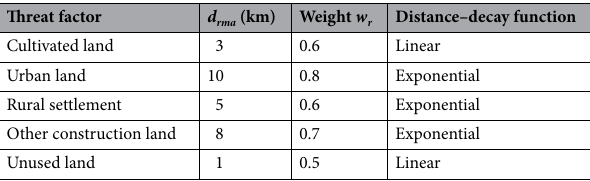
Table 2. The threat factors and related coefficients.